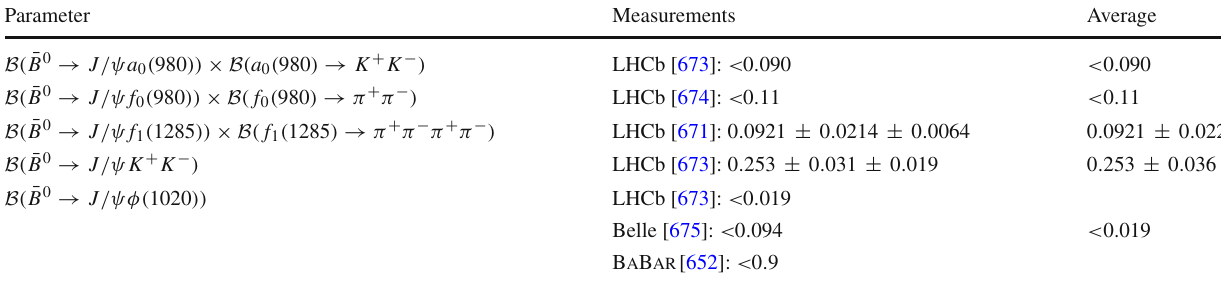
Table 120 Decays to charmonium and light mesons II [ 10 − 5 ] Parameter